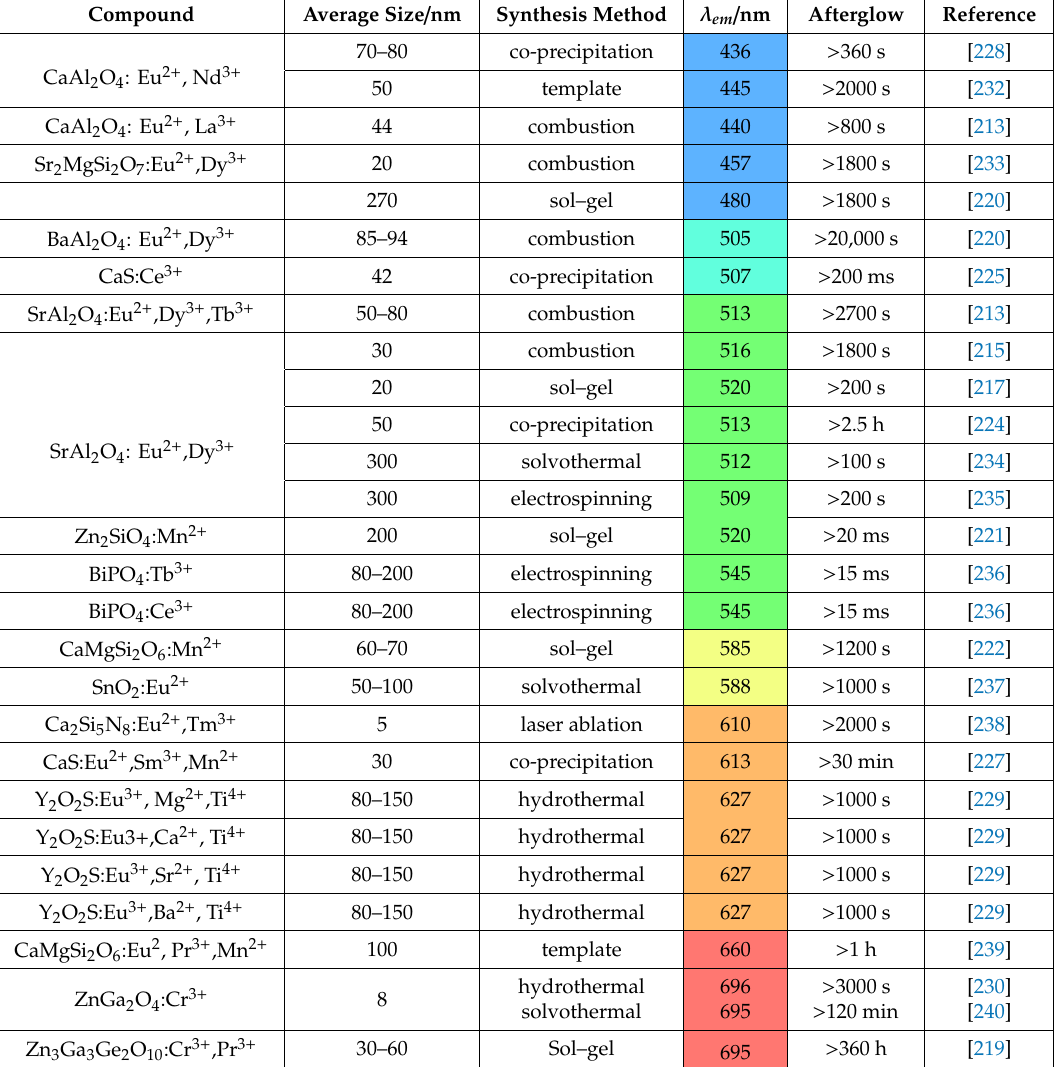
Table 4. Examples of PeL compounds, average size, synthesis method, emission wavelength ( λ exc ), and afterglow duration. Compound Average Size / nm Synthesis Method λ em / nm Afterglow Reference